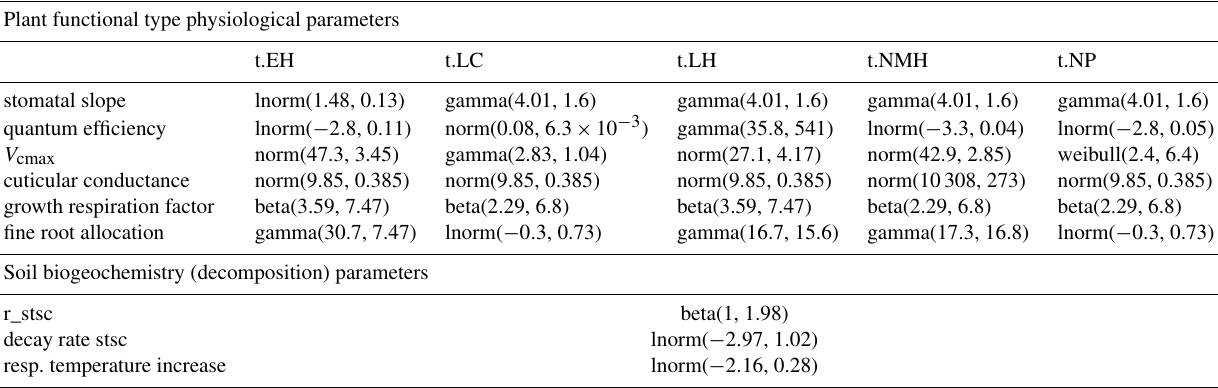
Table A6. The emulator PDA approximated parametric posterior distributions of the targeted ED2 parameters. Plant functional type physiological